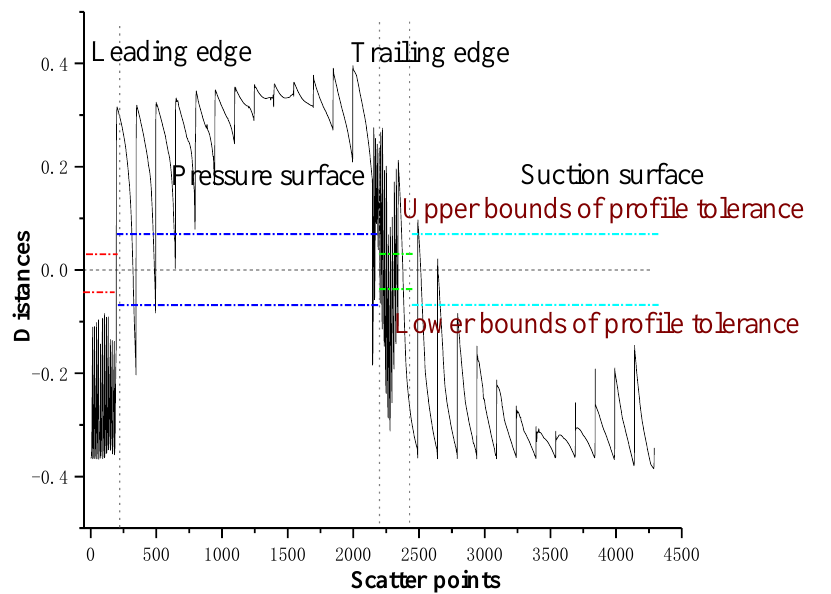
Figure 13. The distances from the profile curves to the tolerance bands with material- constraint optimization.